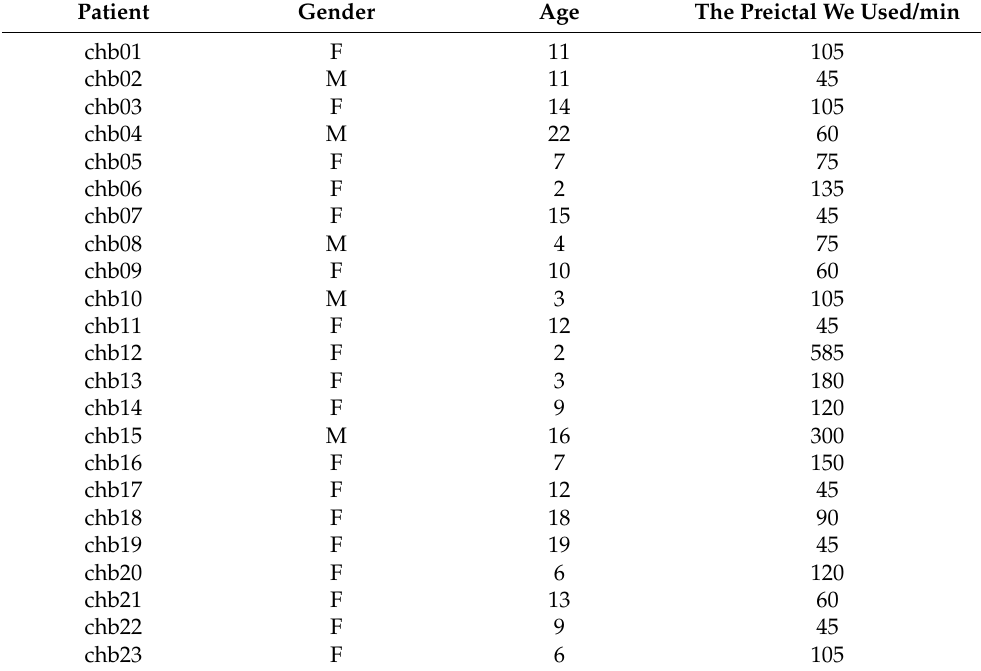
Table 1. Illustrations of the CHB-MIT dataset we used.